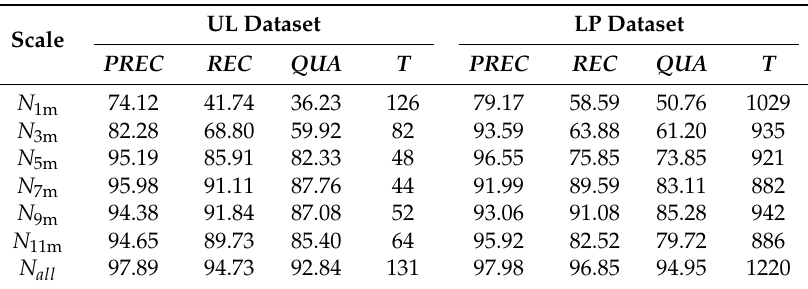
Table 3. PREC , REC , QUA (in %) and T (in s) for different neighborhood scales and two